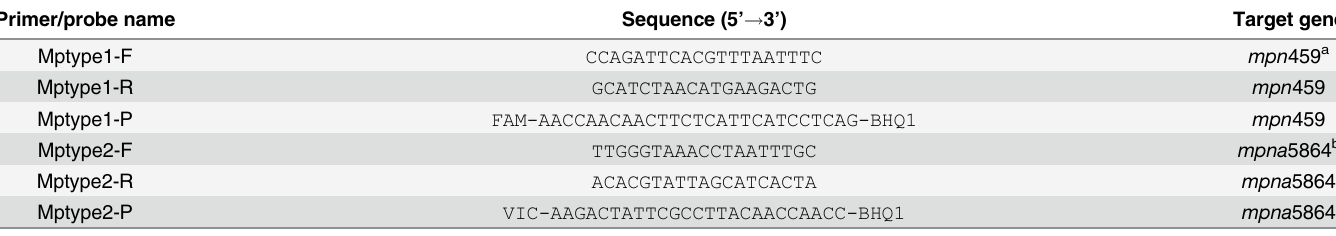
Table 1. Primers and probes used in the duplex real-time PCR